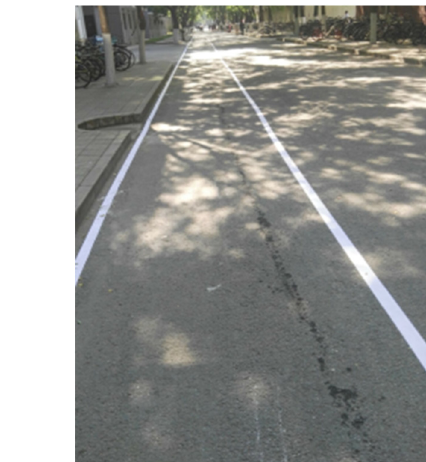
( b ) Figure 3. Cycling workload scenarios—different road edges. ( a ) Curb + marking scenario; ( b ) curb + barrier scenario.